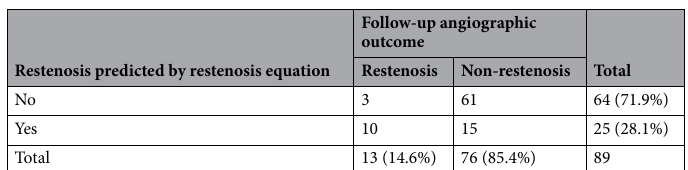
Table 4. Prediction of instent restenosis based on imaging and clinical features of lesions in the validation group (n = 89).